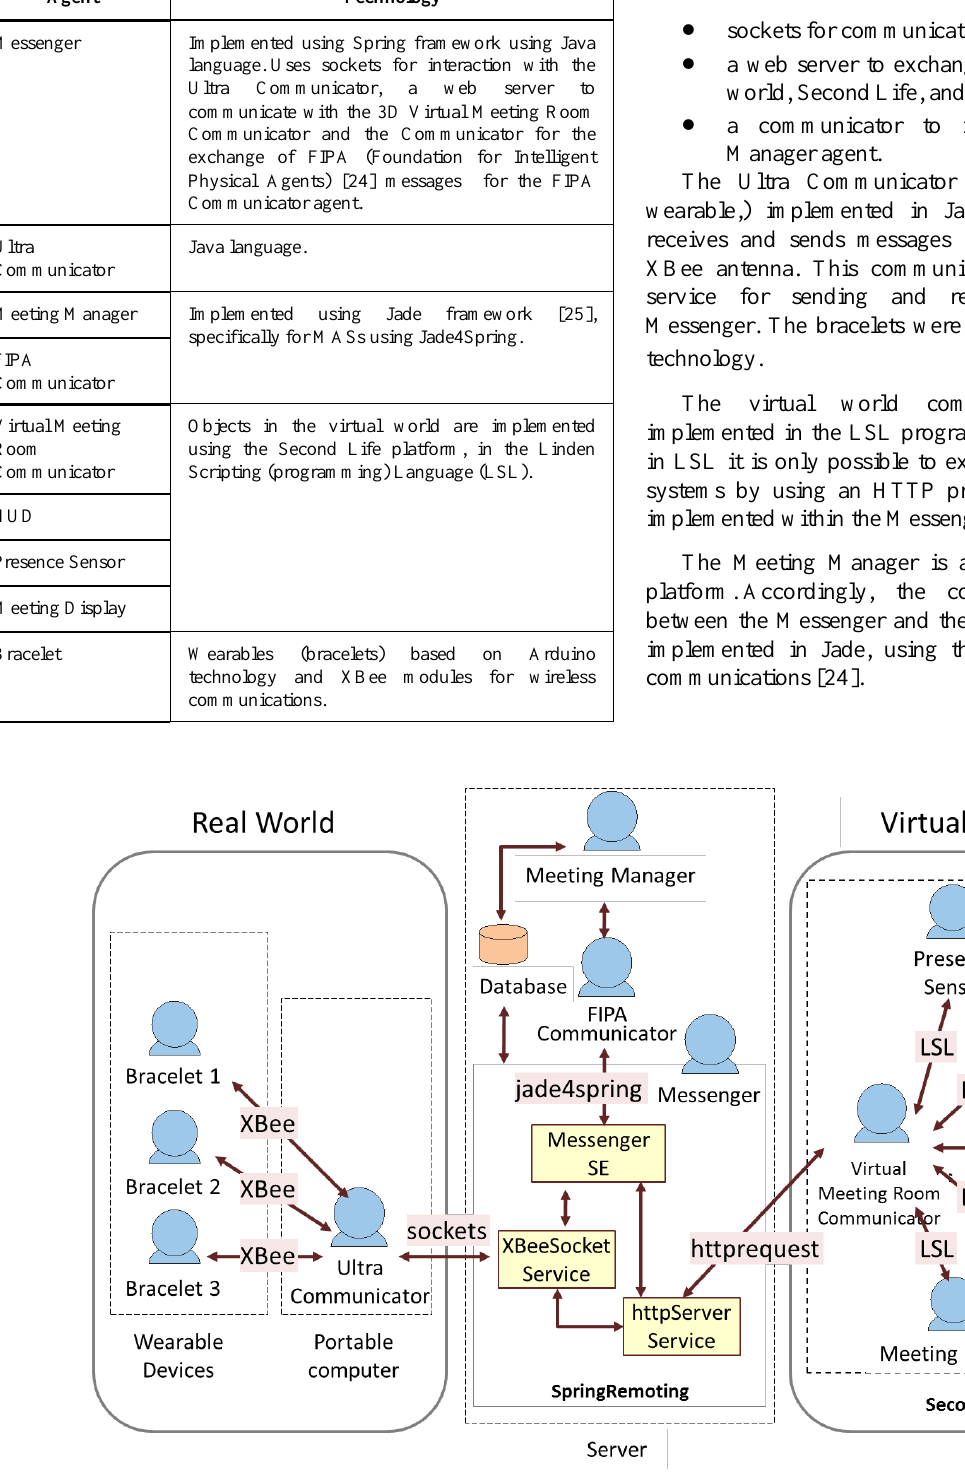
Figure 7. xGroupware architecture implementation